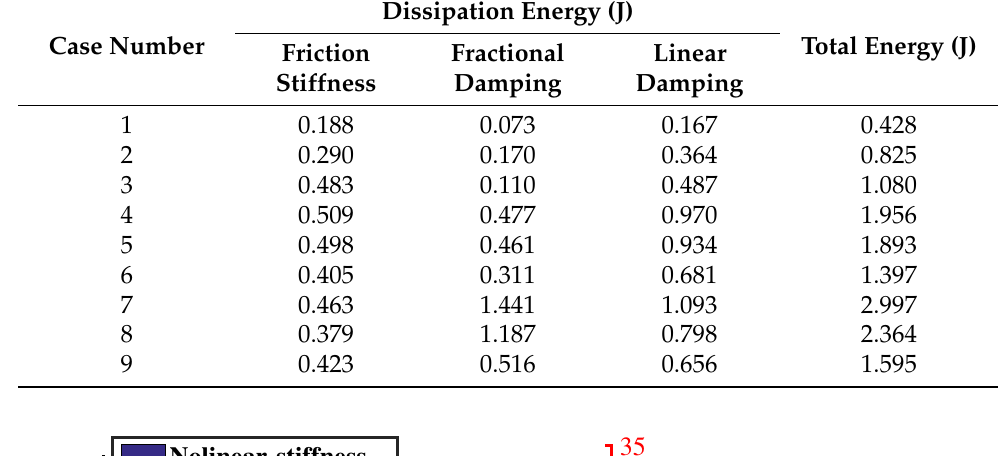
Table 5. Dissipation energies of different restoring forces in the nine drop tests.